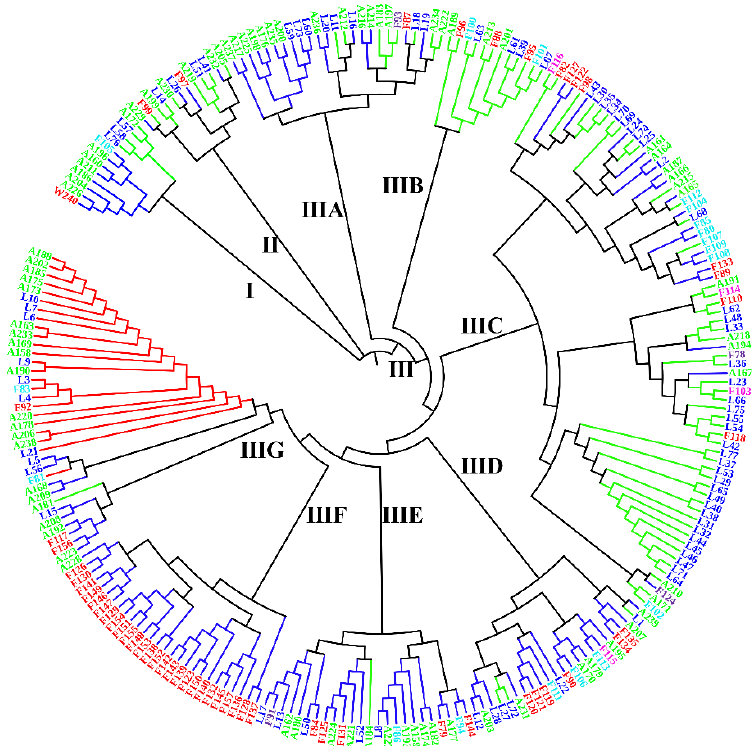
Figure 3. Neighbor-joining tree based on Nei’s genetic distances of 240 accessions using 30 InDel markers. The whole population was divided into three groups ( Ⅰ , Ⅱ , Ⅲ ), while group Ⅲ was further split into seven subgroups ( Ⅲ A, Ⅲ B, Ⅲ C, Ⅲ D, Ⅲ E, Ⅲ F, and Ⅲ G). The labels of each accession were colored according to their geographical origins (CH-Lan = blue, CH-Var = green, AME = red, EA = bright blue, AFR = pink, SEA = purple). The branches of the tree were colored based on the results of the population structure (Pop1 = red, Pop2 = green, Pop3 = blue).